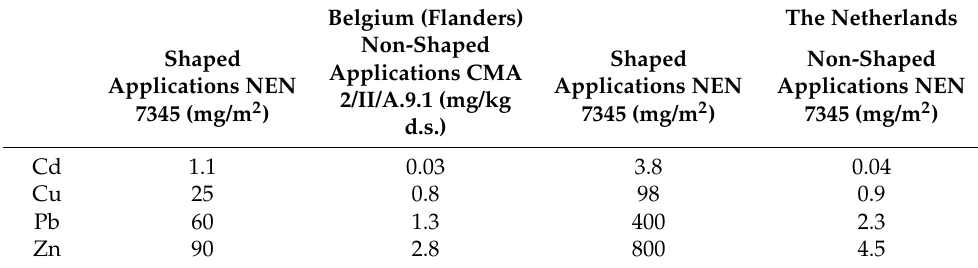
Table 1. Comparison of leaching